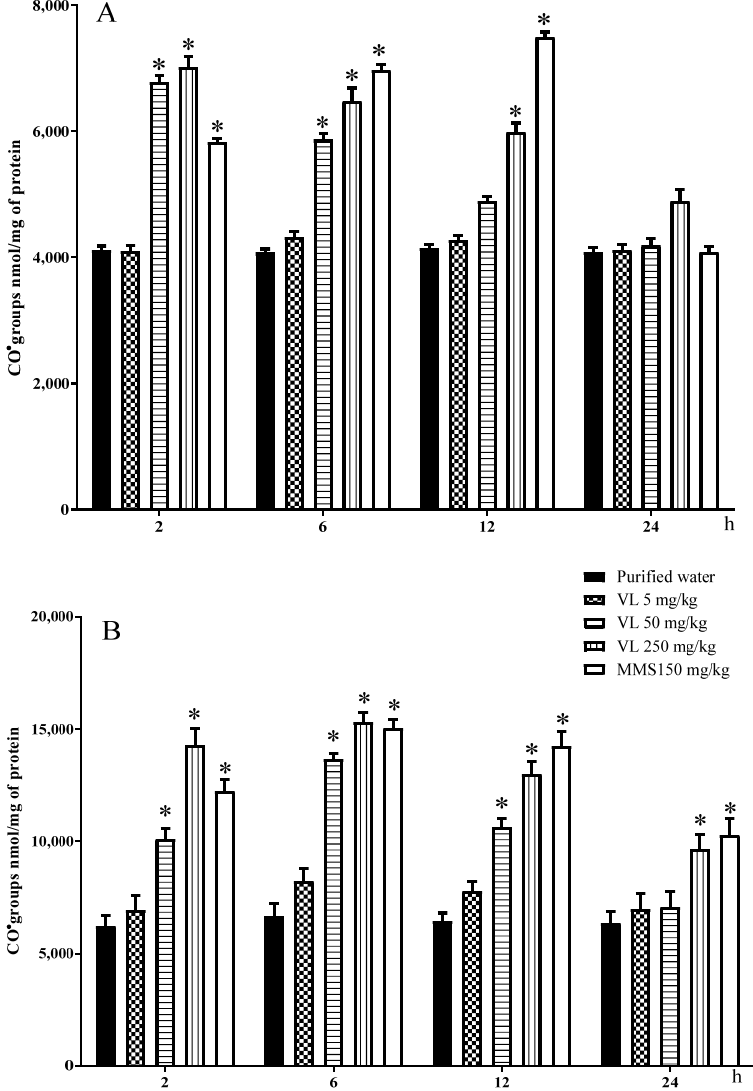
Figure 4. Effect of venlafaxine (VL) on the reactive carbonyl content (CO • ) in the brain of mouse ( A ) and in mouse hepatic tissue ( B ). MMS = methyl methanesulfonate. Each bar represents the mean ± SDM obtained in 5 independent determinations per dose. * Shows statistically significant difference in comparison with the control level. Two-way ANOVA and Tukey tests ( p ≤ 0.05).